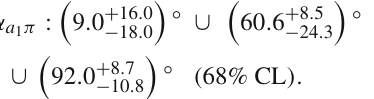
CL, consistent with the value from Eq. (35) obtained for the B 0 → (ρπ) 0 decay. Assuming for simplicity that the lat- ter deviation (Δα) ρπ has the same value in the case of the